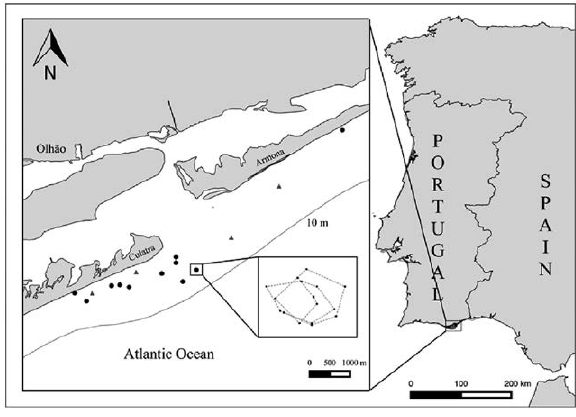
Fig. 1. – Map showing the location of the bivalve fishing surveys performed using SDredge (triangles) and DDredge (circles) along the Algarve coast (southern